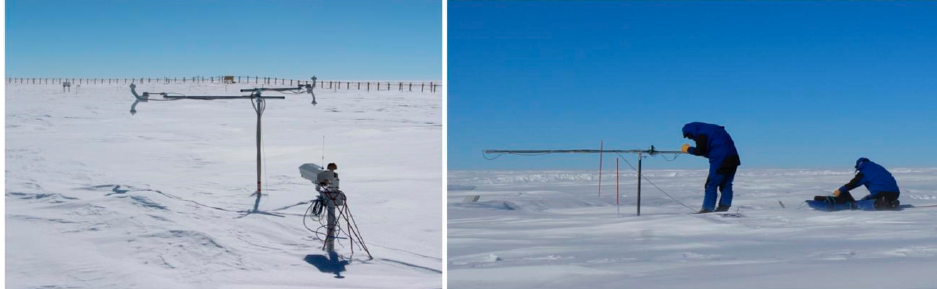
Figure 8. Left : Autosolexs, the automated spectral albedometer at Dome C, Antarctica; right : measuring the surface albedo with the Solalb instrument during the ASUMA traverse in Antarctica.